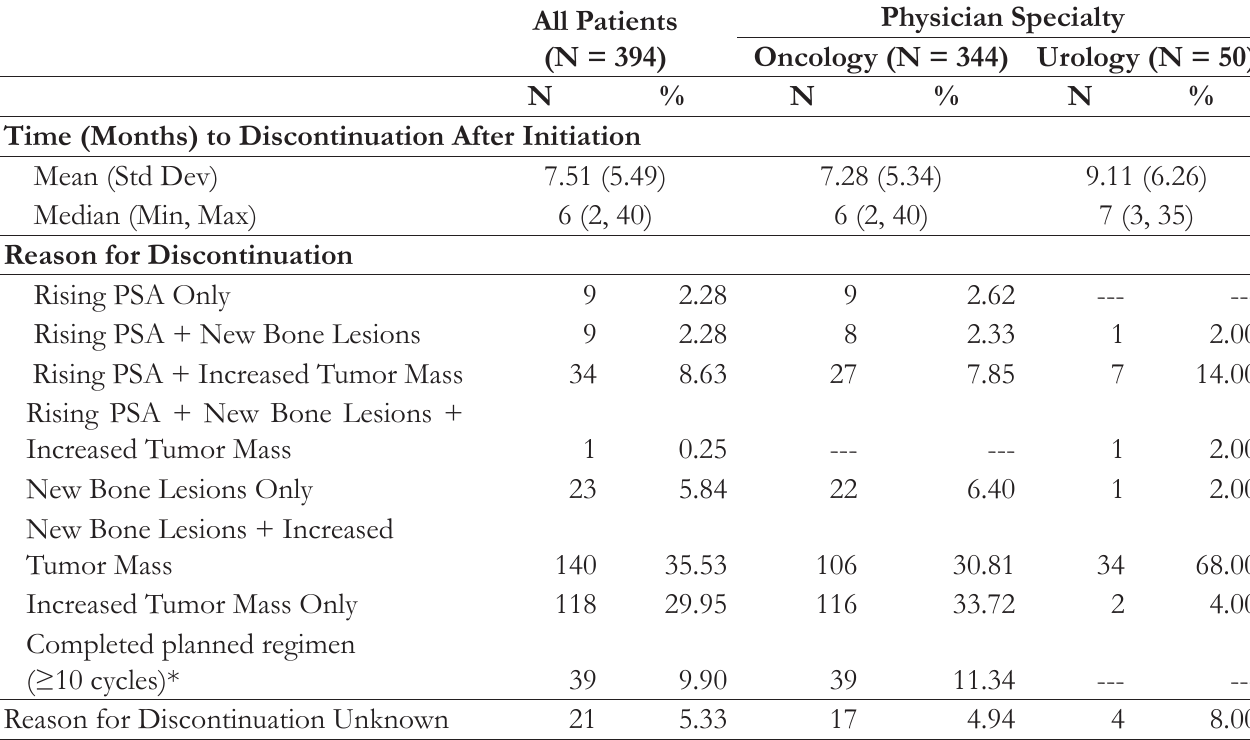
Table 3. Docetaxel Discontinuation Characteristics, by Specialty of Treating Physician